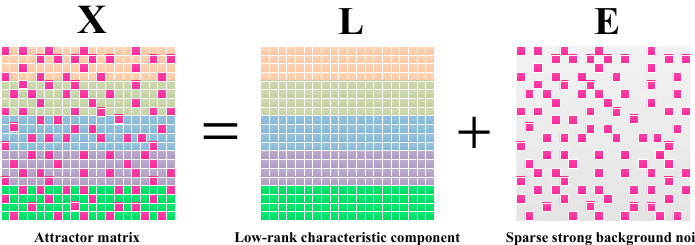
Figure 5. Illustration of the low rank and sparse component decomposition from the attractor matrix by RPCA.